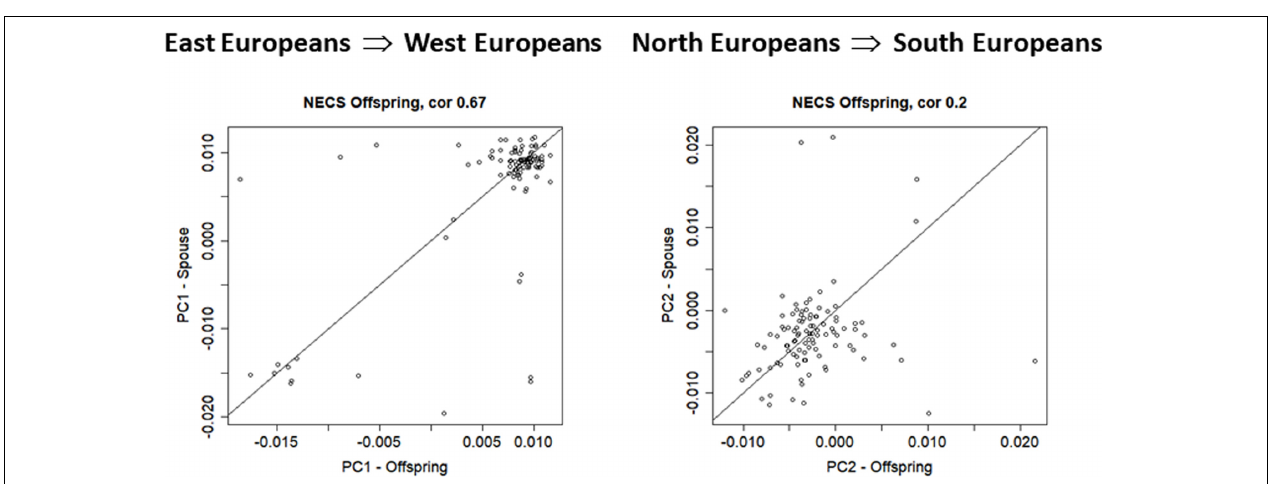
FIGURE 3 | Scatter plot of PC1 and PC2 in the LLFS spouse pairs. Top: proband generation ( N = 155). Bottom: offspring generation ( N = 735). Gold: participants enrolled at the Danish field center.